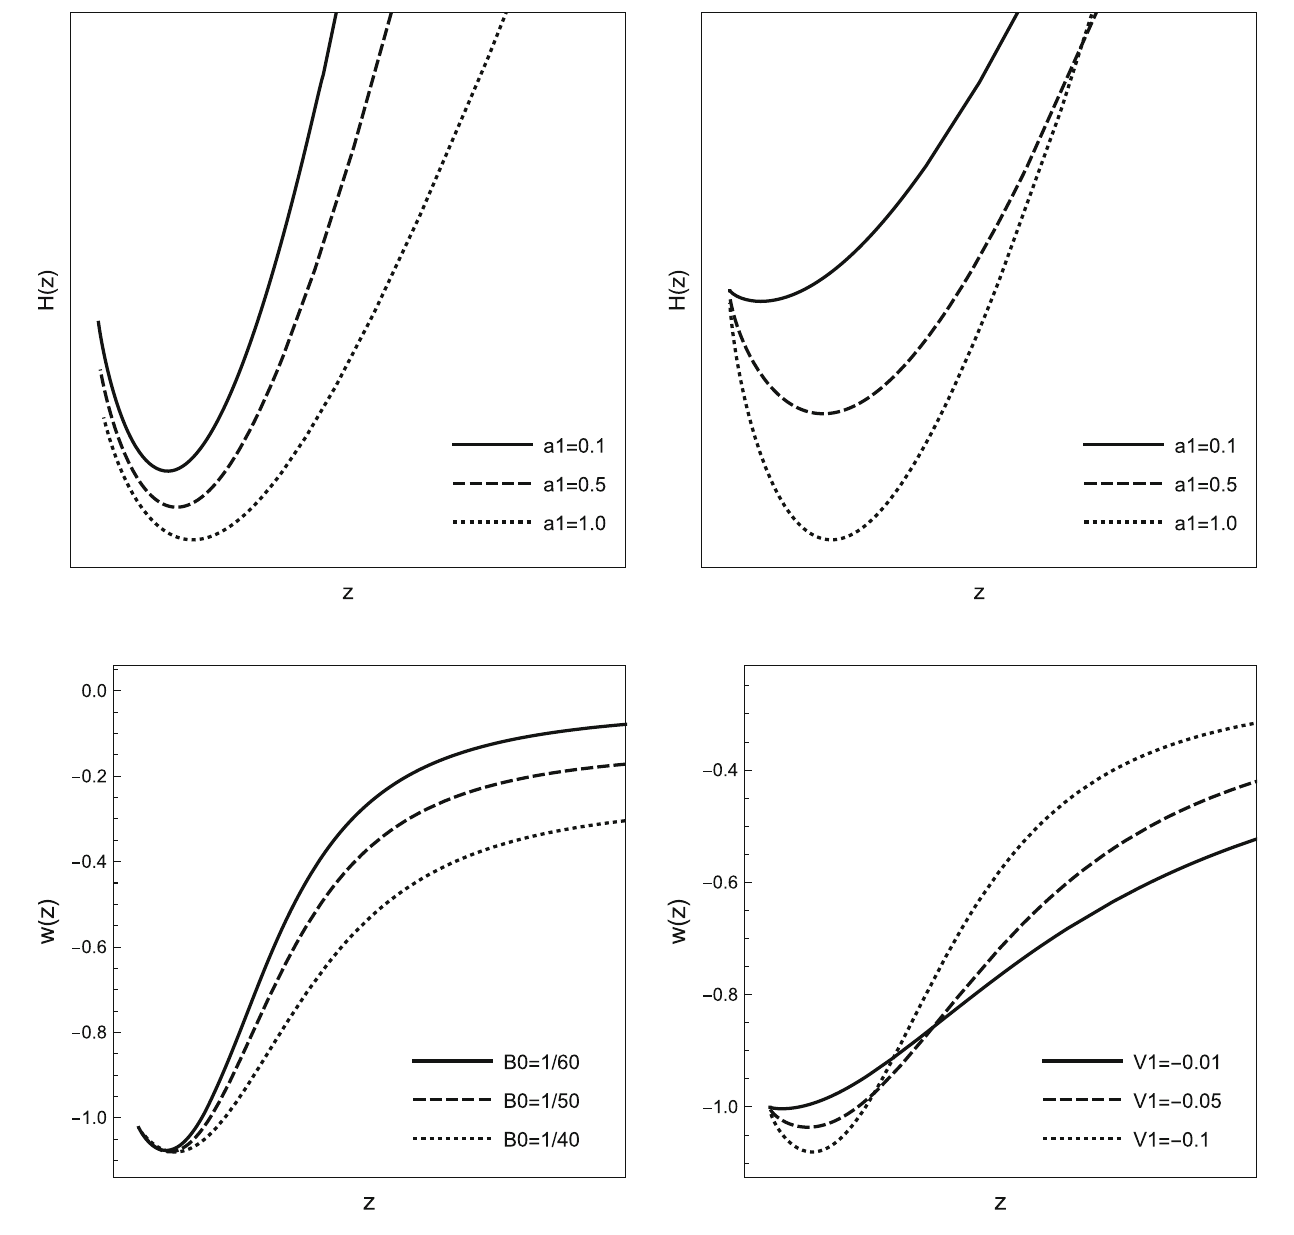
(cid:13) (cid:12) 1 , 1 , 1 . Right figures are for B 0 = 1 of B 0 = 60 50 40 values of V 1 = {− 0 . 01 , − 0 . 05 , − 0 . 1 } . From the plots we observe that the cosmological fluid pass the phantom divide line while the de Sitter universe is a future attractor